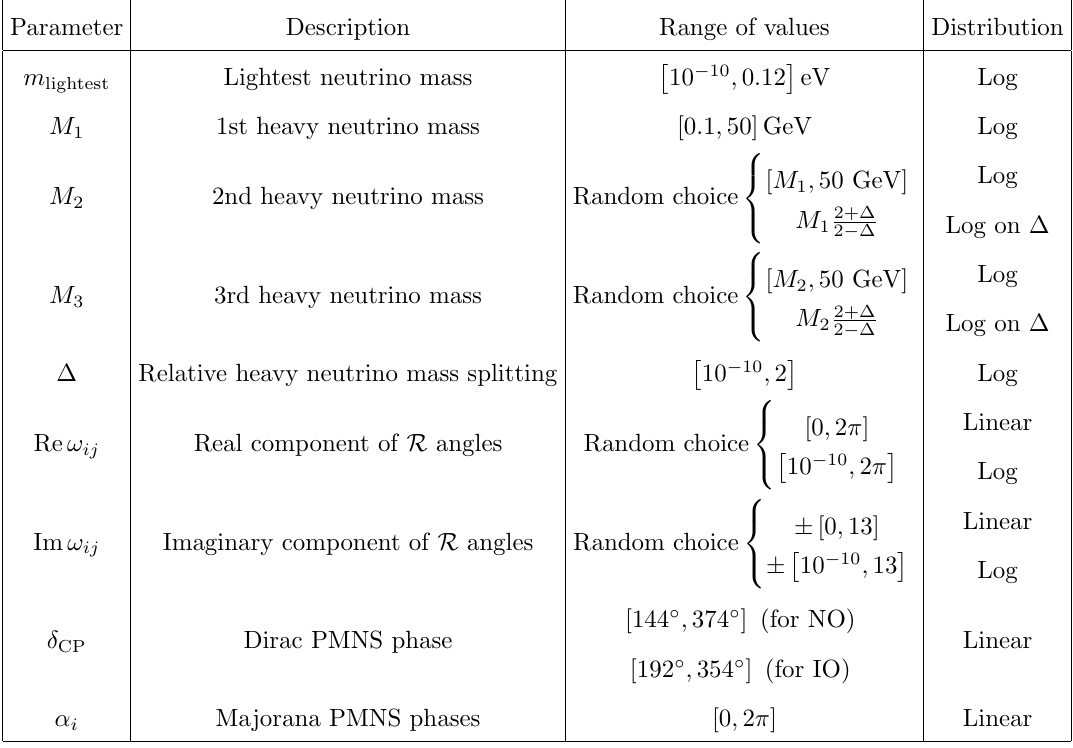
Table 1 . Range of values and distribution of the free parameters sampled in the numerical scan. Random choice means that, in the generation of each point, one of the described alternatives is randomly chosen. The heavy neutrino masses M i are labelled following M 1 < M 2 < M 3